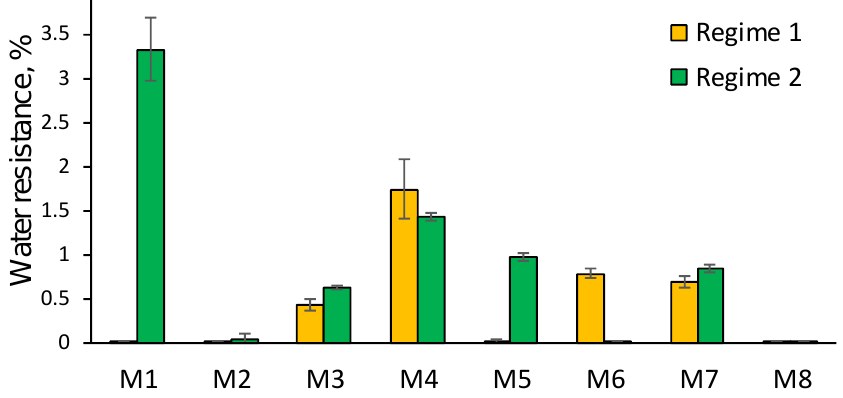
Figure 3. Water resistance of AAC cured in different regimes.